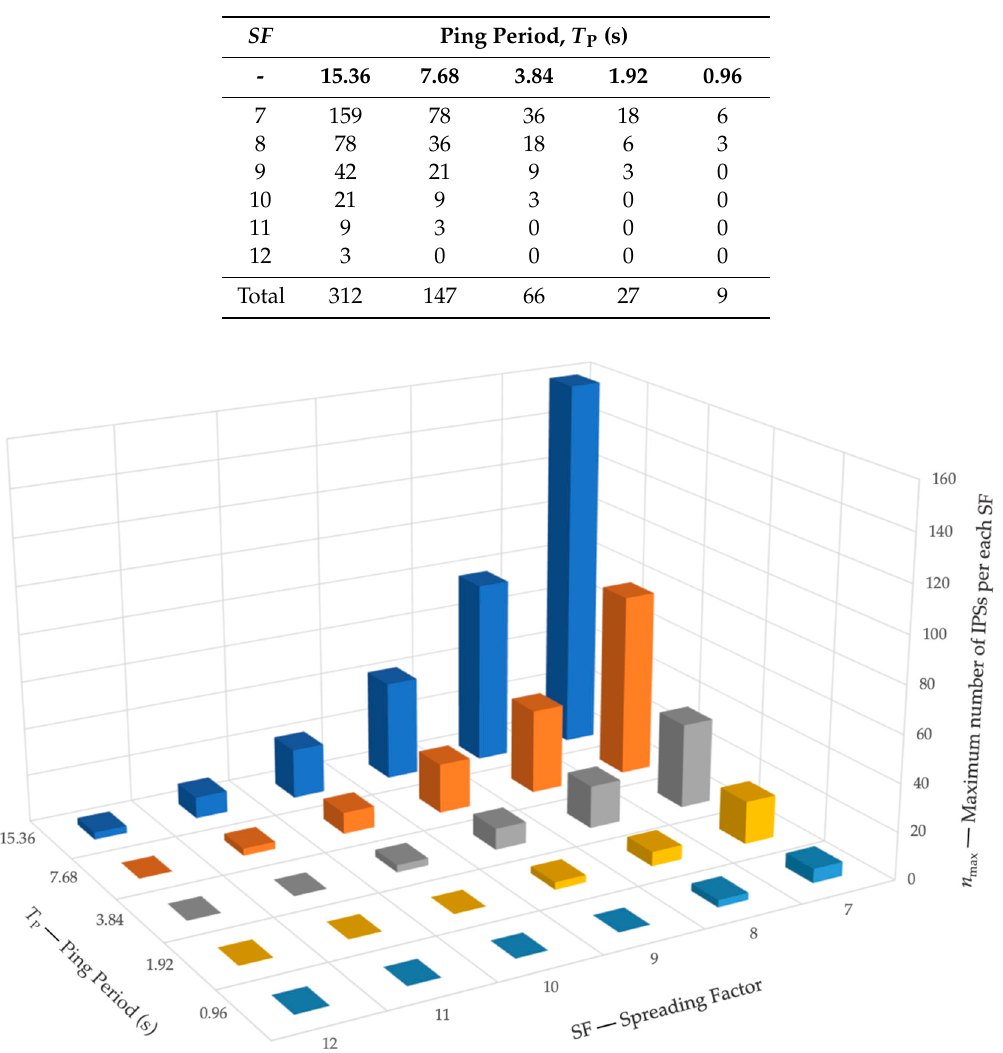
Table 7. Maximum number of coordinated IPSs for each SF (considering the use of all the three compulsory LoRaWAN channels) depending on the selected ping period, in the scenario with up to 312 mapped devices. SF : Spreading Factor.